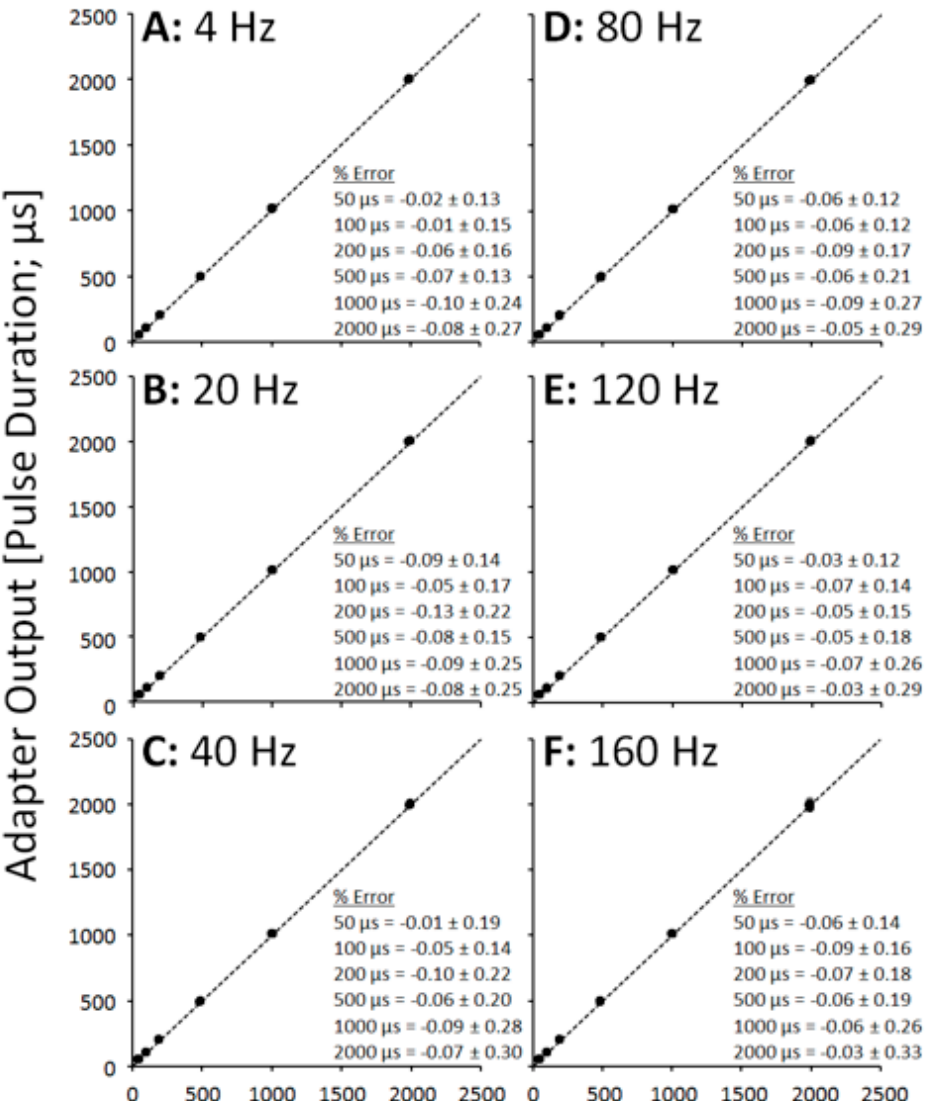
Figure 4. Scatter plots showing adapter pulse duration outputs vs. stimulator pulse duration outputs across frequencies ( A – F ).